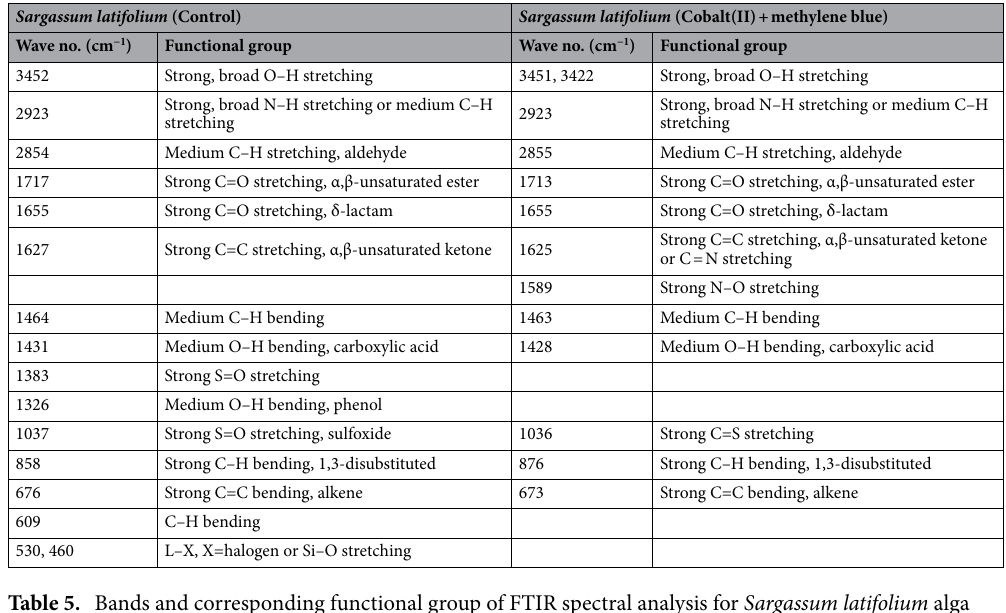
Table 5. Bands and corresponding functional group of FTIR spectral analysis for Sargassum latifolium alga before and after biosorption